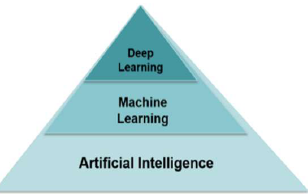
Figure 1. Difference between deep learning and machine learning.